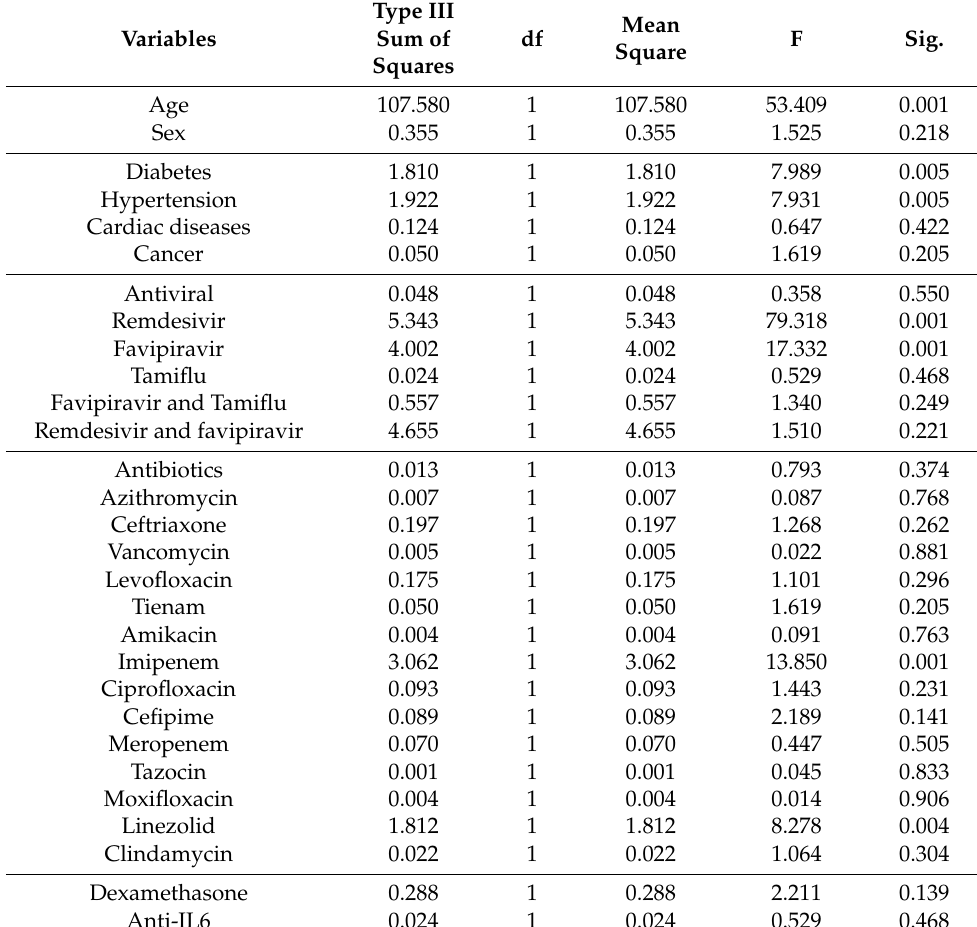
Table 4. Multivariate test of different variables and their effects on the survival rate in patients with severe forms of